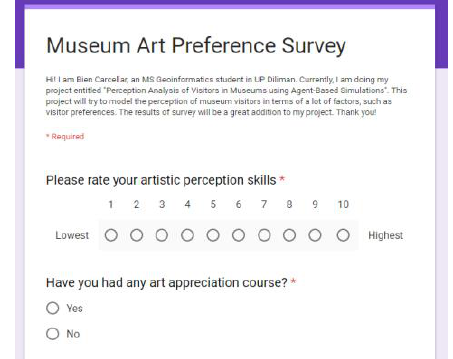
Figure 9. A screenshot of the online museum art preference